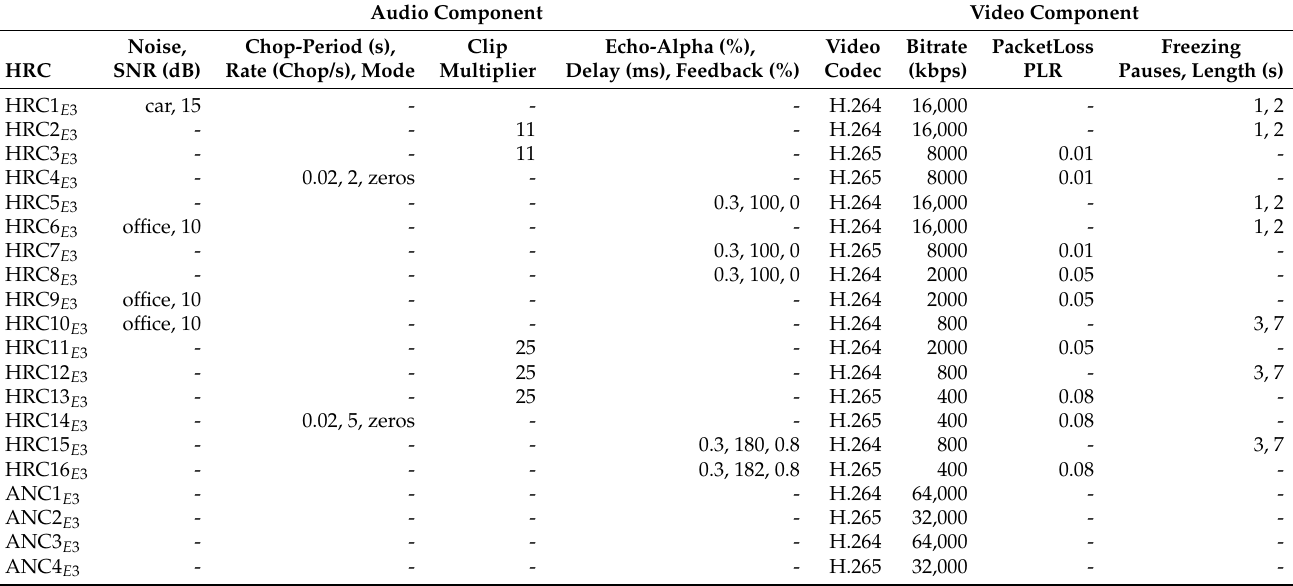
Table 9. HRC and ANC parameters used in Experiment